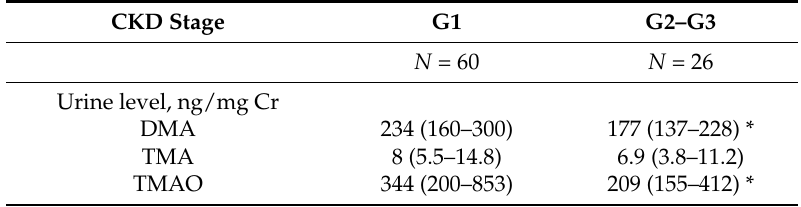
Table 3. Urinary levels of DMA, TMA, and TMAO in children with CKD stage G1–G3.